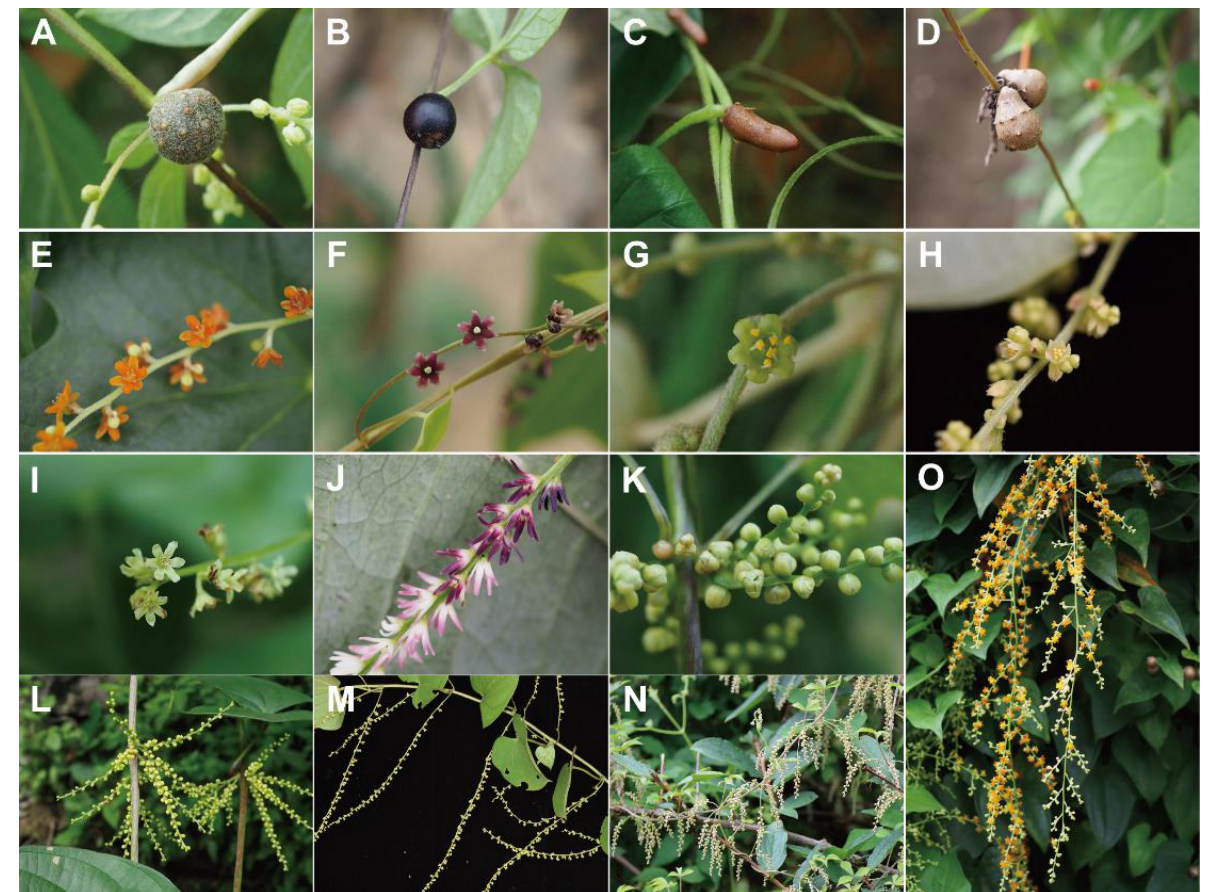
Figure 1. Characters related to reproduction showing morphological diversity of Dioscorea . ( A – D ) Bulbils. ( E – H ) Floral color. ( I – K ) Perianth opening degree. ( L – O ) Inflorescence architecture. ( A ) D. kamoonensis . ( B ) D. melanophyma . ( C , N ) D. delavayi . ( D , K ) D. polystachya . ( E , O ) D. futschauensis . ( F ) D. zingiberensis . ( G ) D. yunnanensis . ( H ) D. subcalva . ( I ) D. tokoro. ( J ) D. bulbifera . ( L ) D.exalata . ( M ) D.